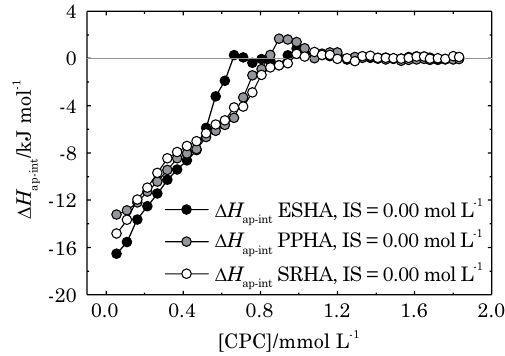
Figure 3. Apparent molar enthalpy change (∆ H ap-int ) of the interaction between elliott soil, Pahokee peat, and Suwannee river humic acids (eSha, PPha, and Srha) and hexadecylpyridinium chloride monohydrate (cPc) surfactant in carbonate buffer at 25 o c and 0.0 mol L -1 ionic strength